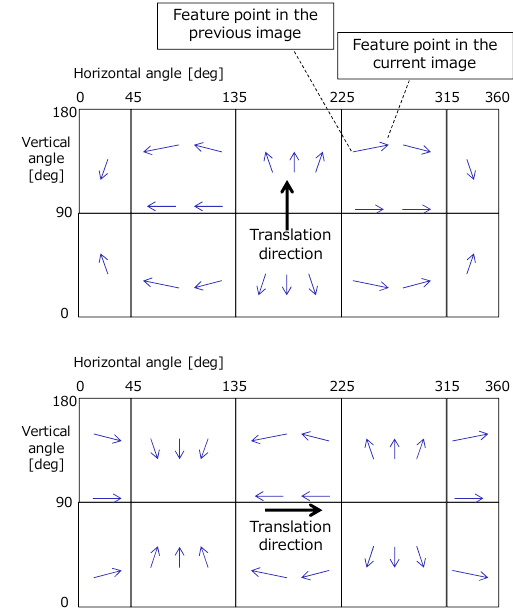
Figure 2. Optical flow estimation for camera